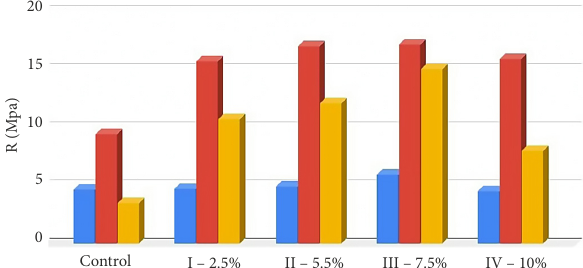
Figure 3. Physical and technical characteristics of gypsum composites after 28 days (blue – bending strength, red – compressive strength, yellow – strength in a water-saturated